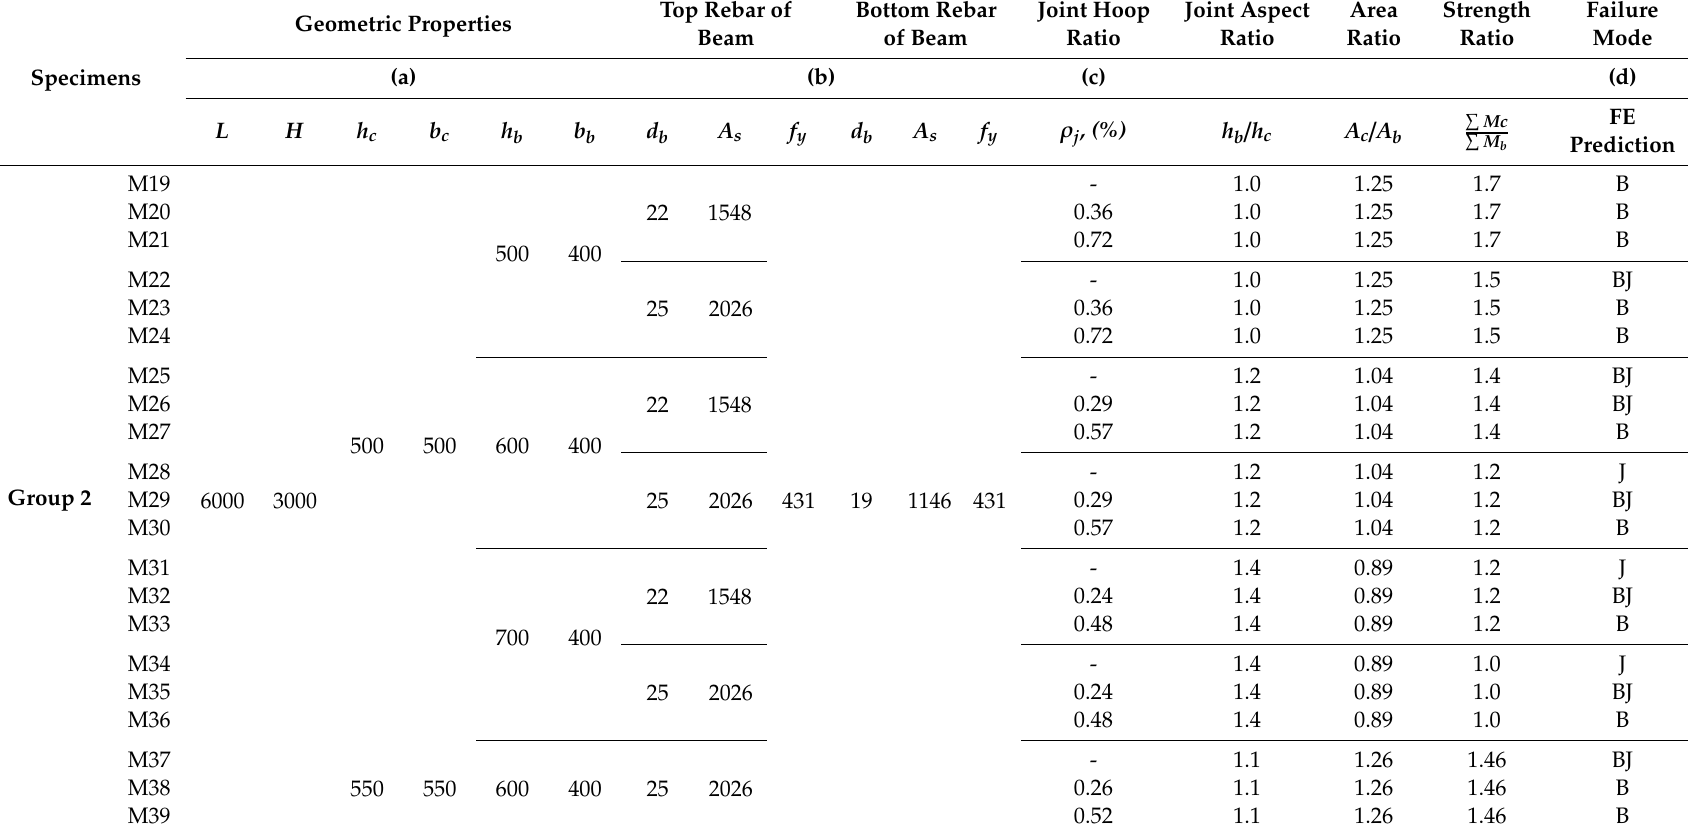
Table A3 lists the main analysis parameters of 50 existing beam–column joints that were used to verify the proposed